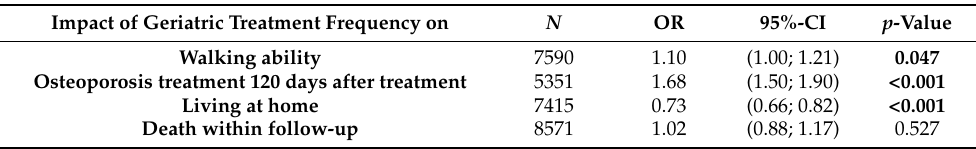
Table 3. Multivariable logistic regression analysis of the impact of increased geriatric treatment frequency on various outcomes after 120 days of